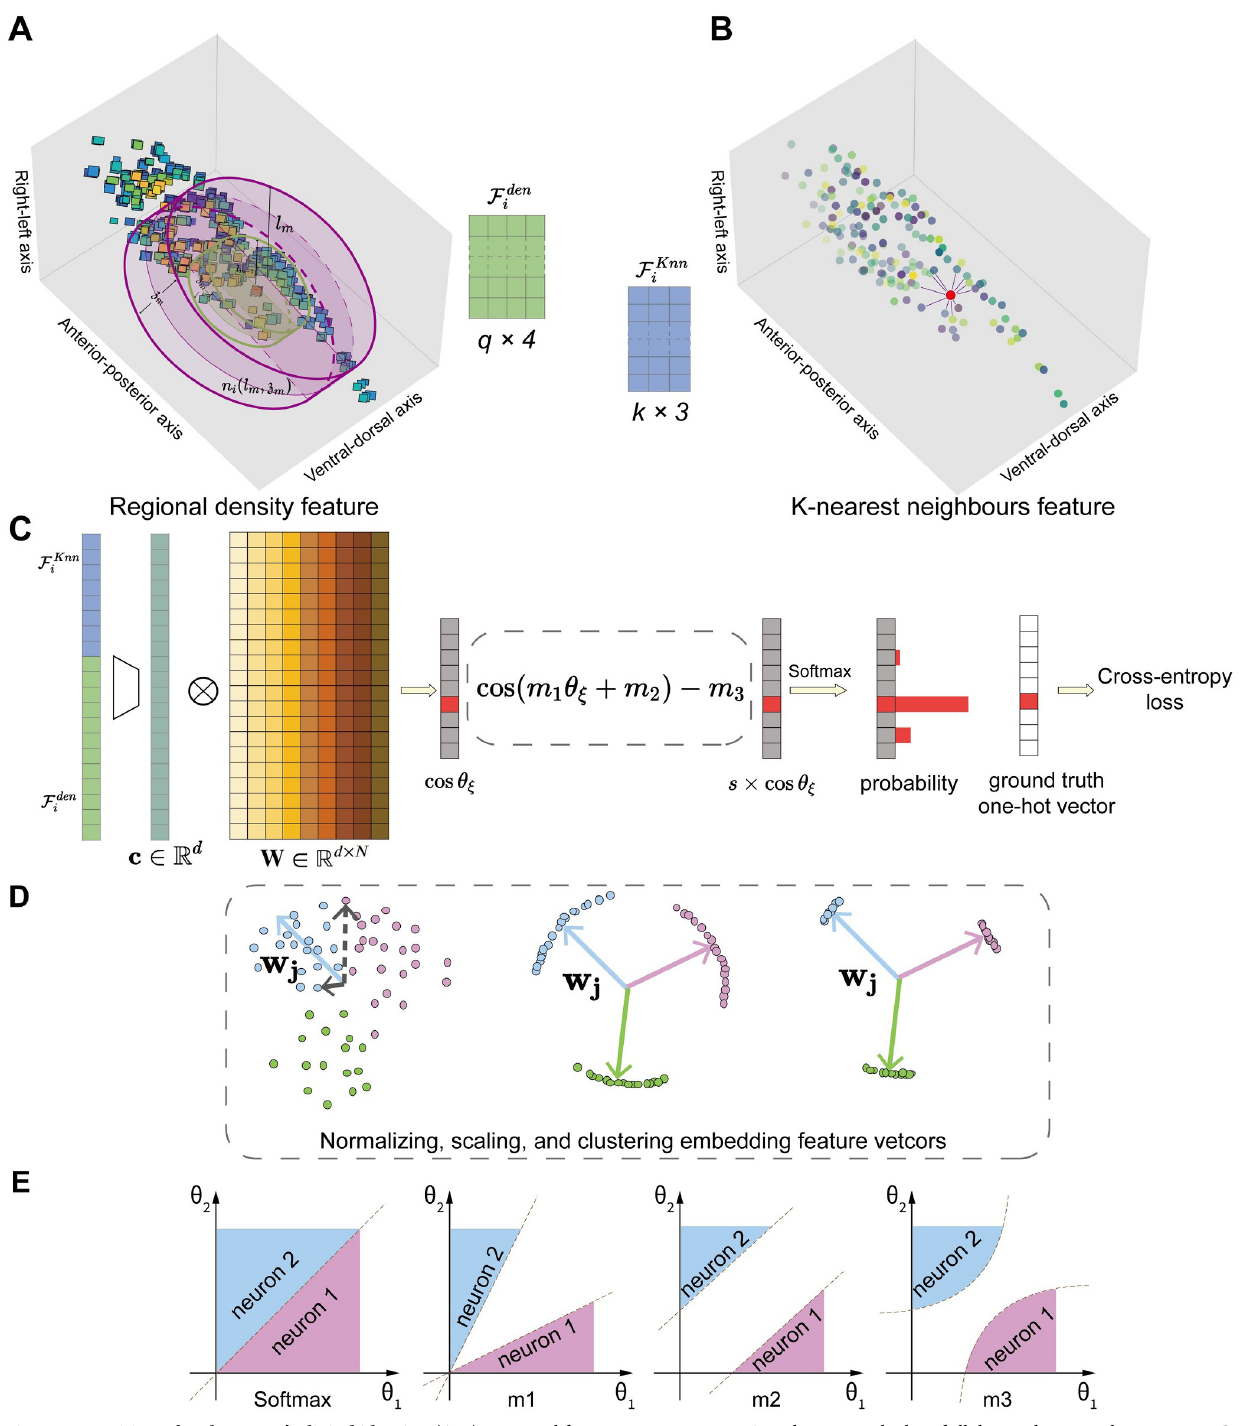
Fig 6. Recognition of each neuron’s digital identity. (A,B) Neuronal feature engineering. In A , 3-dimensional atlas of all detected neuronal regions in a C. to the origin in the C. elegans coordinate system. The neuronal density feature is constructed by elegans head region. The red point assigns neuron N i counting the number of neuronal regions n between two color-coded concentric cylinders with expanding radii l and heights z . The n neuronal regions are subdivided into 4 territories (see Section Stage 4: Neuron recognition for details). The length of a density vector is q × 4, where q + 1 is the number of concentric cylinders. In B , radiating lines connect N with its K-nearest neighbours (neuron objects), whose 3 coordinates are used as positional features. i in A and F Knn in B . (C) A multi-class recognition neuronal network. First, the input feature vector The feature vector is constructed by concatenating F den i i is transformed into a high-dimensional embedding vector c . Second, the final linear layer computes the cosine similarity between c and each column vector